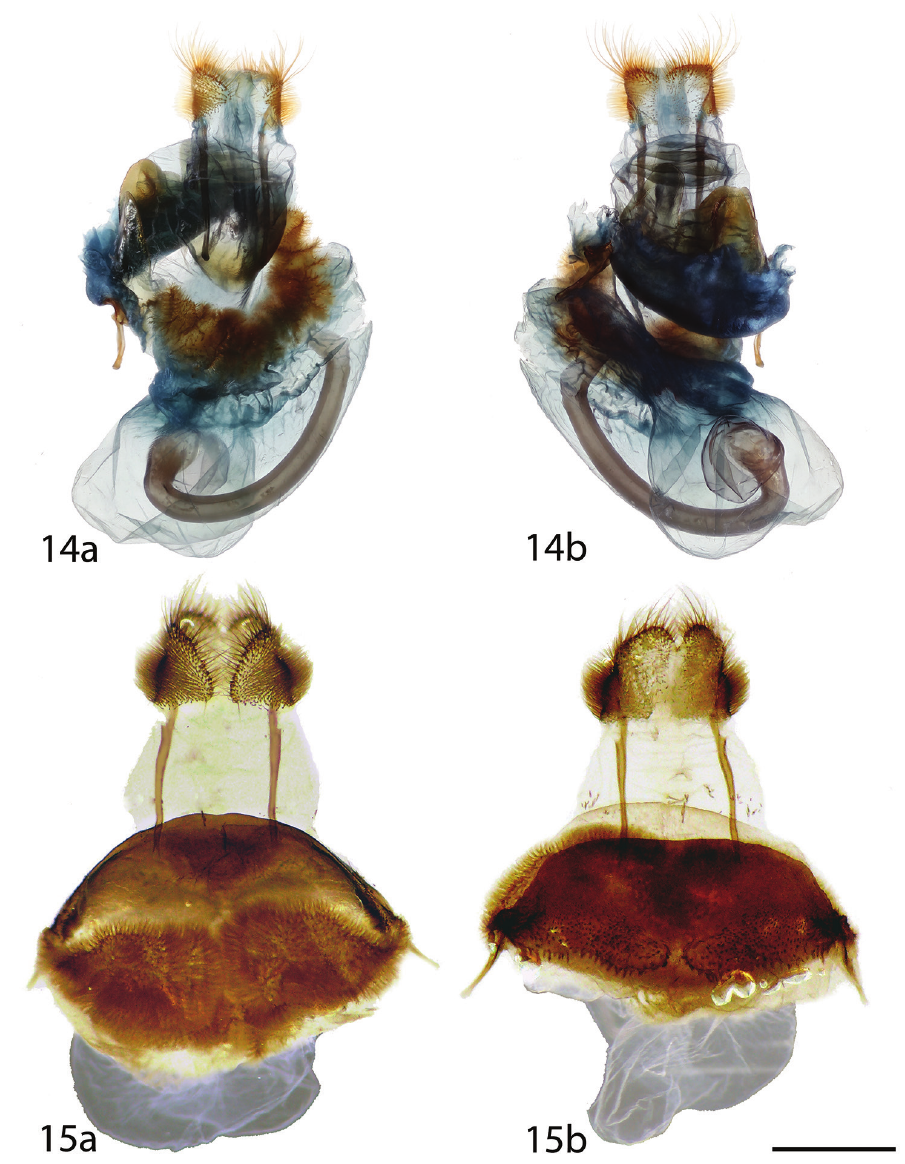
tação Florestal, Cabeça do Veado, 1100 m, St Laurent diss.: 3-14-16:8 (CNC) 15 T. fuscosa , Brazil,